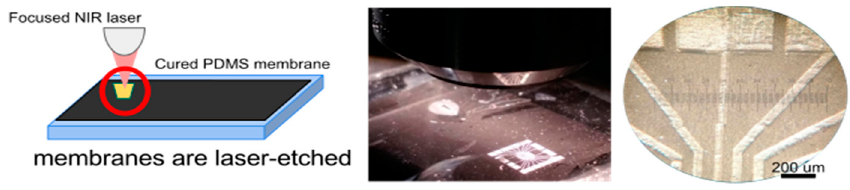
Figure 10. Example of a micropatterned design transferred to PDMS.